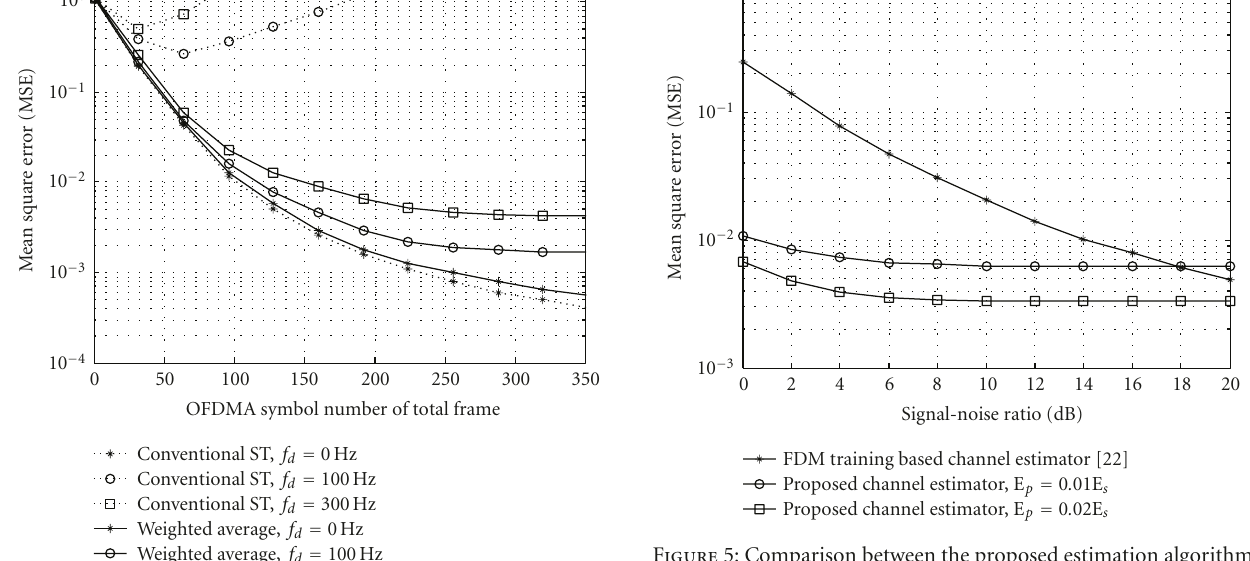
Figure 5: Comparison between the proposed estimation algorithm and that of [14] with of f d = 300 Hz.